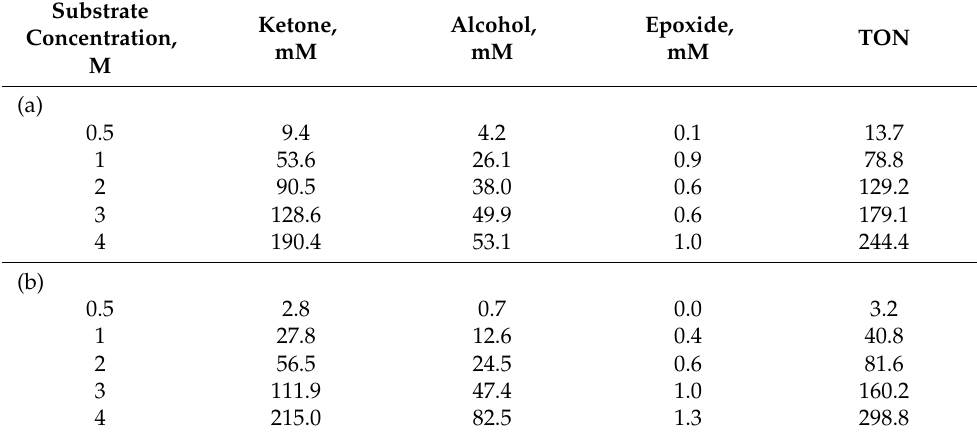
Table 2. Oxidation of cyclohexene with (a) air (p O2 = 0.2 atm) or (b) dioxygen (p O2 = 1 atm)